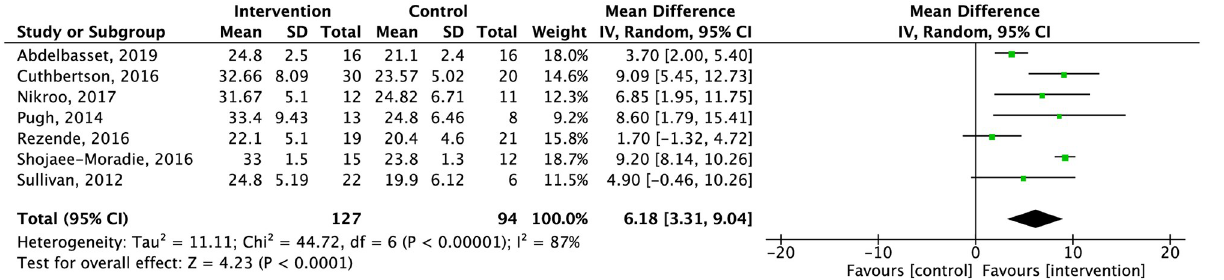
Fig 4. Effect of exercise alone compared to the control in oxygen